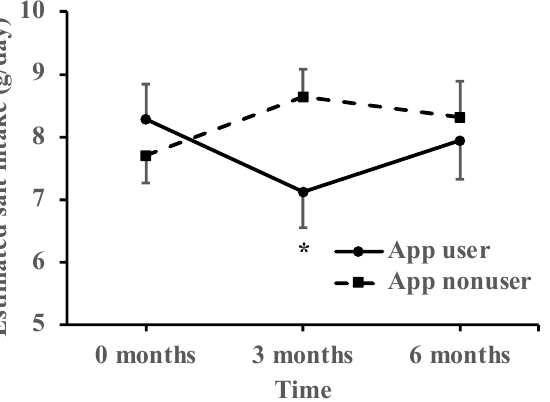
Figure 3. Salt intake estimated by 24 h urine collection at baseline after the use of the Gohan Coach application (3 months) and during the maintenance phase (6 months). * p value = 0.03 versus control group. Error bars represent standard error of mean.